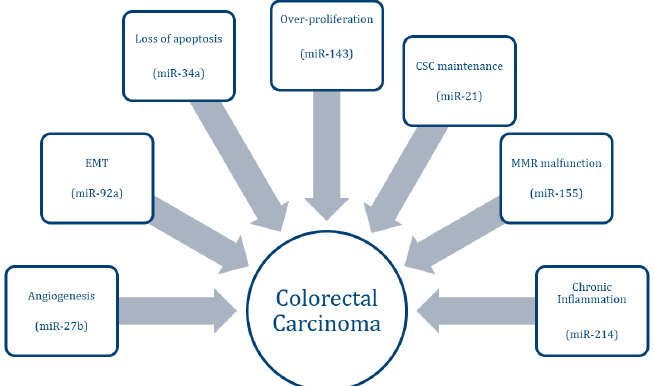
Figure 1. Pathways associated with colorectal cancer progression and examples of associated Figure MicroRNAs (miRNAs).